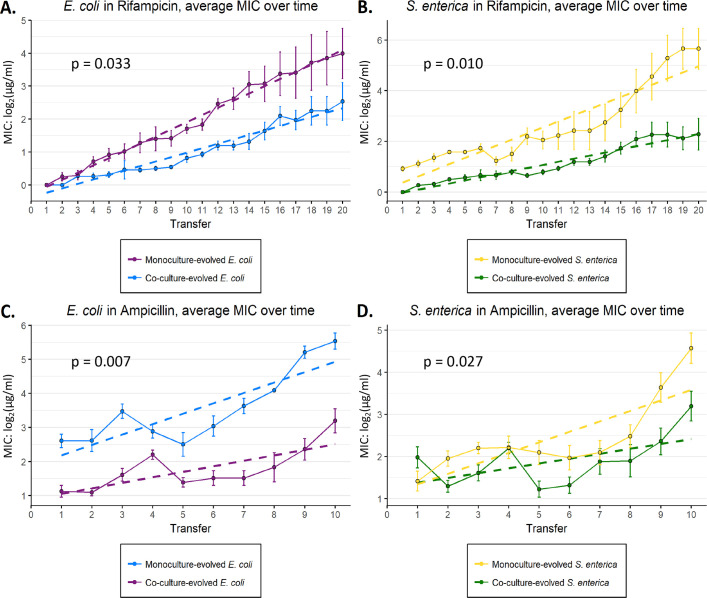
Resistance evolves more slowly in co-culture-evolved populations vs. monoculture-evolved populations. Six replicate populations each of monocultures and co-cultures were evolved along a rifampicin gradient (A-B) or an ampicillin gradient (C-D); gradients were identical for monocultures and co-cultures. Population MICs for each species (E. coli
A, C; S. enterica
B, D) were measured each transfer and the resulting MICs plotted. Statistical analysis was performed using a mixed-effects model with a randomized slope for each replicate within a culture type. The fitted slopes for each treatment are indicated by the dashed lines. P-values are for the interaction term between passage and culture type. Error bars represent the standard deviation of MIC among the six replicates.